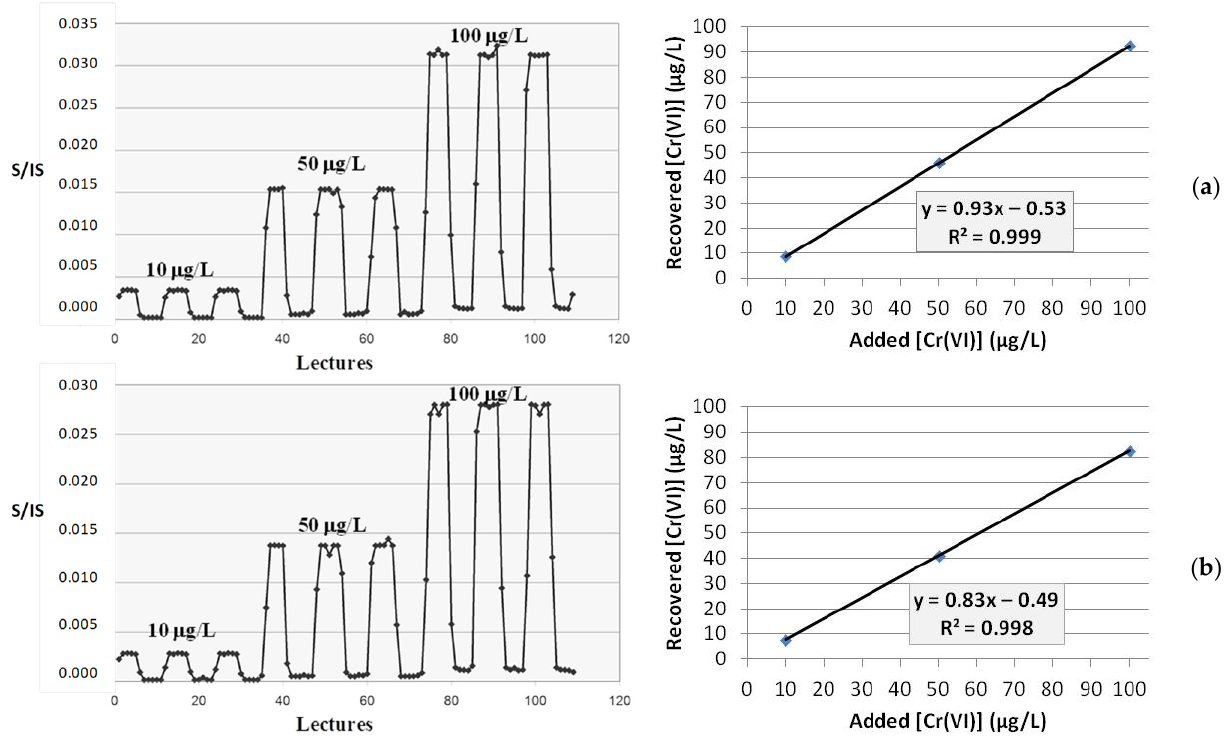
Figure 7. On-line reading of solutions of ( a ) tap water and ( b ) eluate of urban solid waste fortified with increasing amounts of Cr(VI) in the range of 10–100 µg/L.